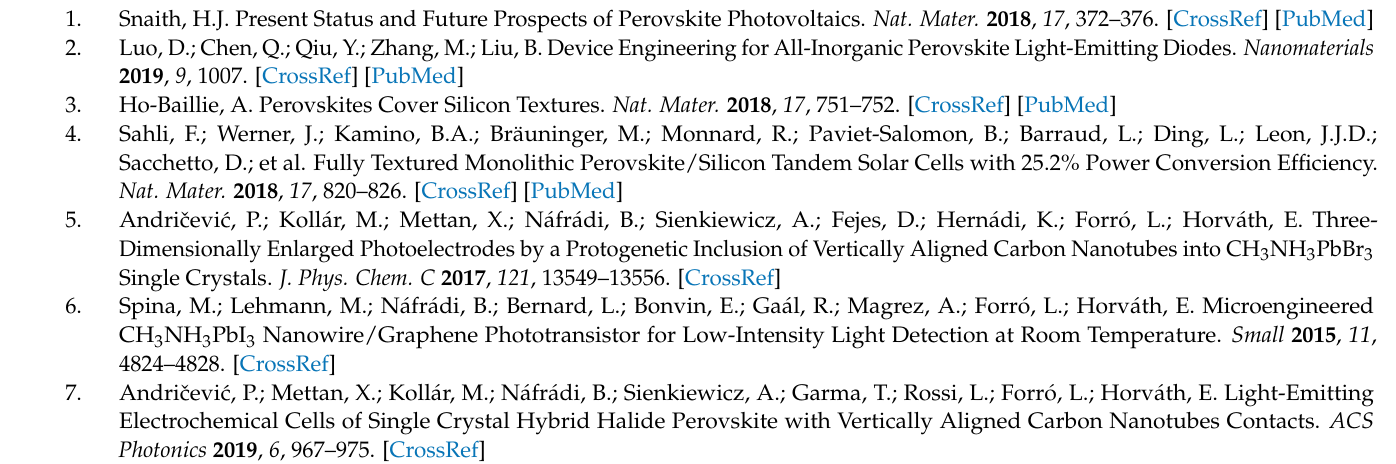
Figure S3. Comparison of response of three types of MA 3 Bi 2 Br 9 sensor with commercial one; Figure S4. Differential thermogravimetric analysis of MA 3 Bi 2 Br 9 ; Figure S5. XRD profiles